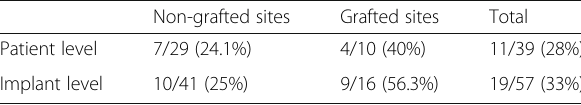
Table 2 Disease resolution between the non-grafted and grafted implant